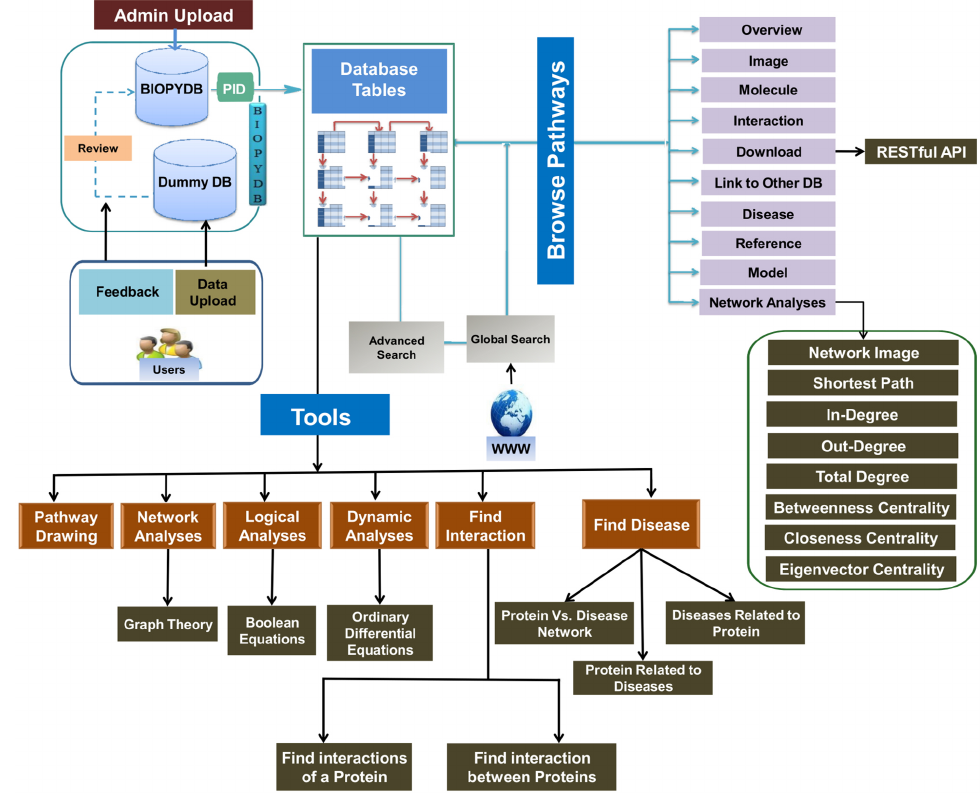
Figure 4: Schematic diagram of BIOPYDB database